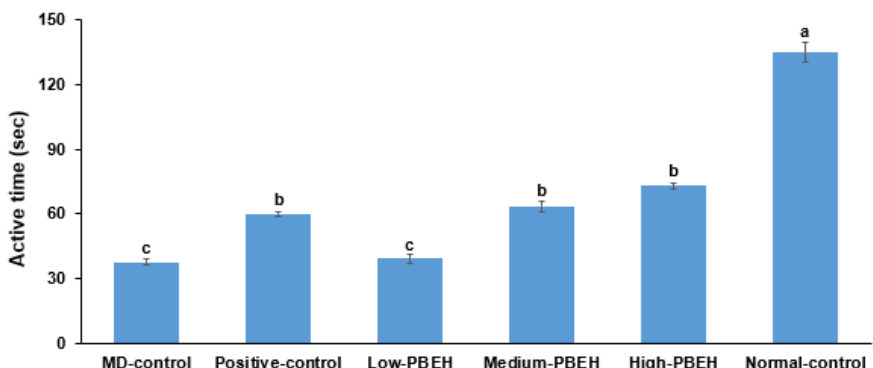
Figure 2. Depression measurement by forced swimming test. Male rats had intraperitoneal injections of scopolamine (2 mg/kg body weight/day) at 30 min after daily feeding of casein (MD-control), porcine brain enzyme hydrolysates (PBEH; 7 mg total nitrogen/mL) at 0.053 mL (Low-PBEH), 0.159 mL (Medium-PBEH), 0.478 mL (High-PBEH), or 10 mg donepezil (Positive-control) per kilo- gram body weight per day for six weeks. Bars and error bars represent the means ± standard deviations ( n = 10). a–c Different superscript letters on the bars indicate a significant difference among the groups by Tukey test at p < 0.05.